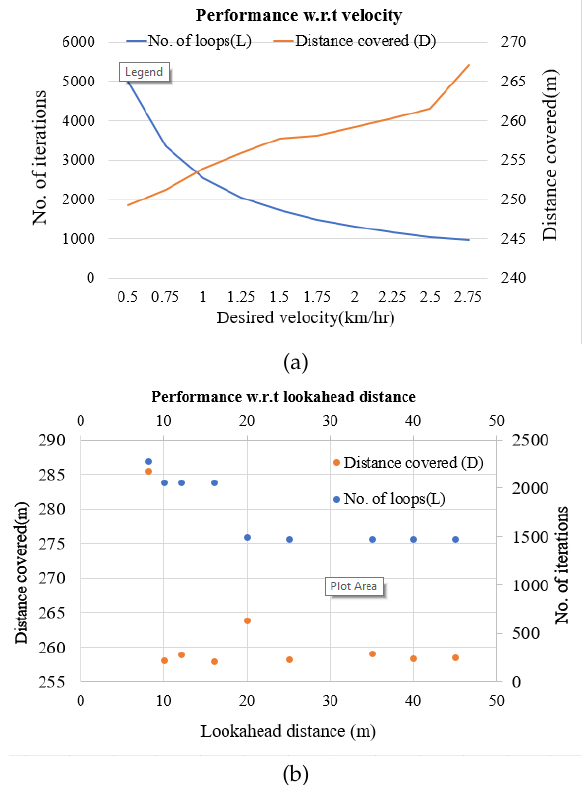
Fig. 4. (a) Performance plot under varying velocity of robot. (b) Performance plot under varying lookahead